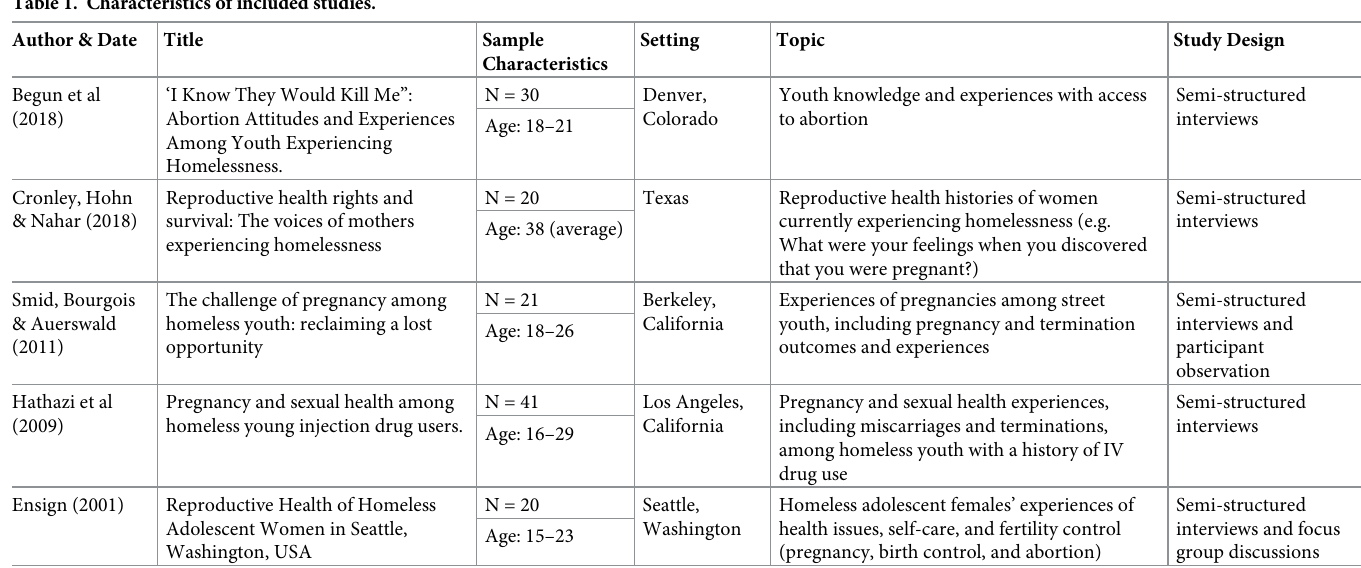
Table 1. Characteristics of included